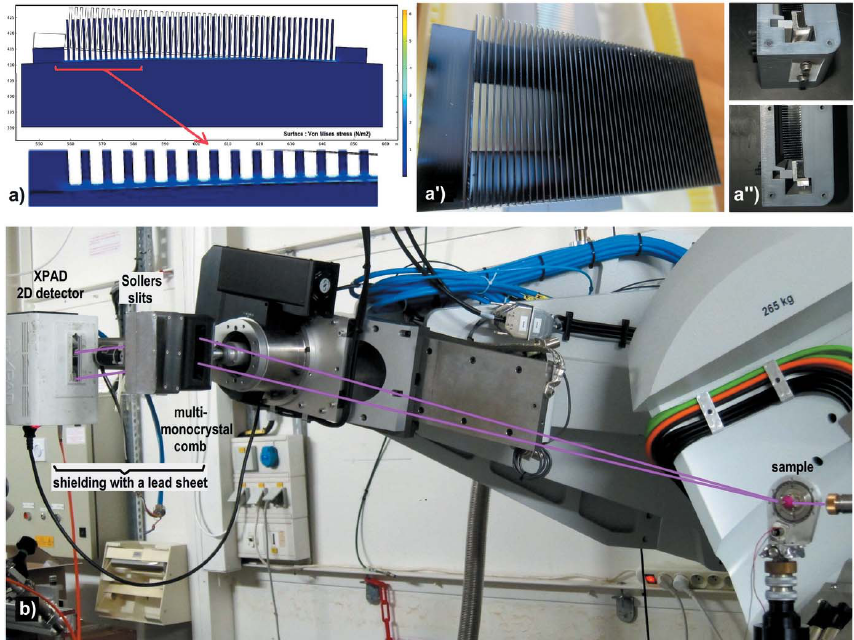
Figure 3 Photographs of the components of the MAD system using the single-crystal-comb and Soller- collimator blocks which are optimized to filter X-ray beams in the 22–46 keV energy range and photograph of their installation on the goniometer of the D2AM beamline. ( a ) Distribution of stresses in the single-crystal-comb during its bending (no stresses ! many stresses corresponds to dark blue ! light blue ! green ! yellow ! orange); stresses are always less than 3 N m (cid:6) 2 (only blue colours) – the hole located under the Si(111) blades of this block has greatly reduced these stresses. ( a 0 ) Photograph of this single-crystal-comb cut in a single-crystal block of silicon and generating 50 single-crystal Si(111) blades – see also its hole located under all Si(111) blades. ( a 00 ) This single-crystal-comb is adjusted with a fixing system on a rigid 3D printed support which imposes its LogSpiral curvature generating the orientations of the Si(111) crystal blades with a 0.1 (cid:2) pitch; enlargement of this fixing system. ( b ) Installation of this small MAD system on the (cid:2) A axis of the D2AM beamline goniometer, with the Soller-collimator block and the 2D photon-counting detector on the corresponding 2 (cid:2) A arm; once the energy has been chosen, it is important to place a shielding lead sheet between the single-crystal-comb, the Soller-collimator block and the 2D detector (see the note on the left side of the photograph) in order to protect the filtered beam paths from environmental background noise; this photograph was taken before the installation of this lead shielding